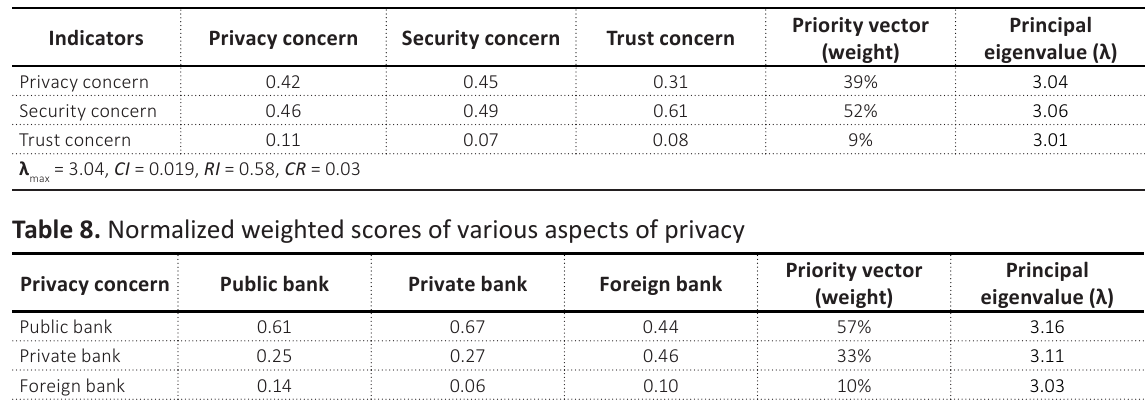
Table 7. Normalized weighted scores of various aspects of security risk Indicators